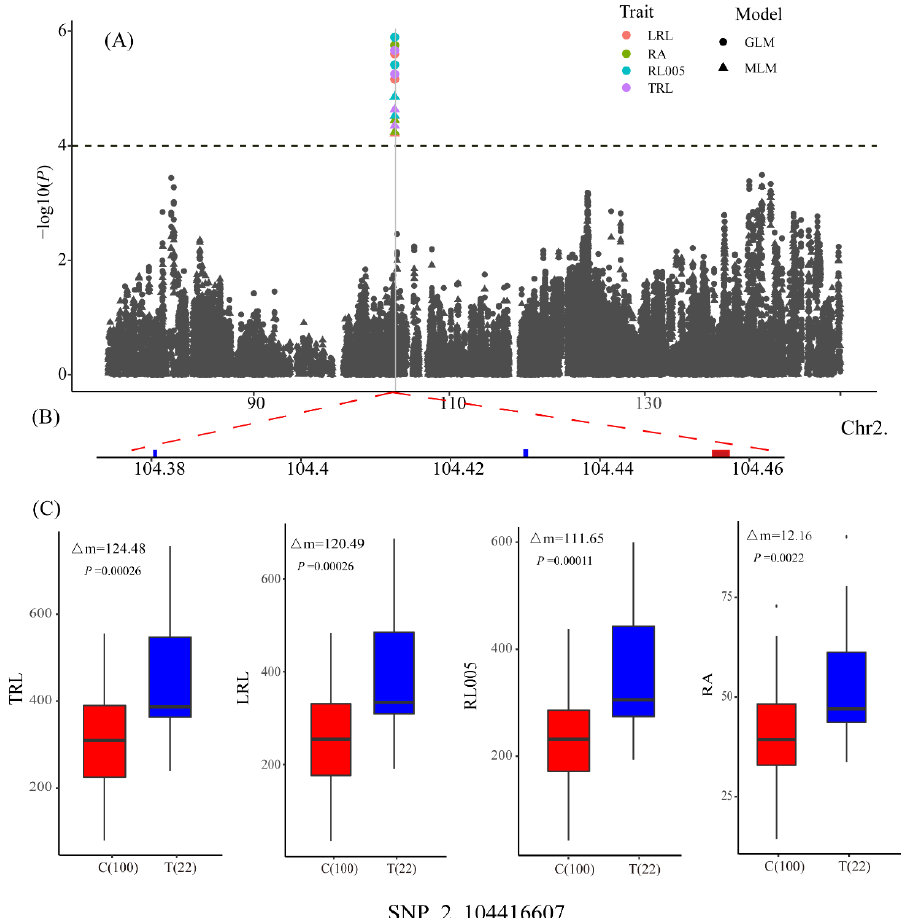
Figure 4. Association analysis of pleiotropic SNP_2_104416607 with LRL, RA, RL005, and TRL. (A)